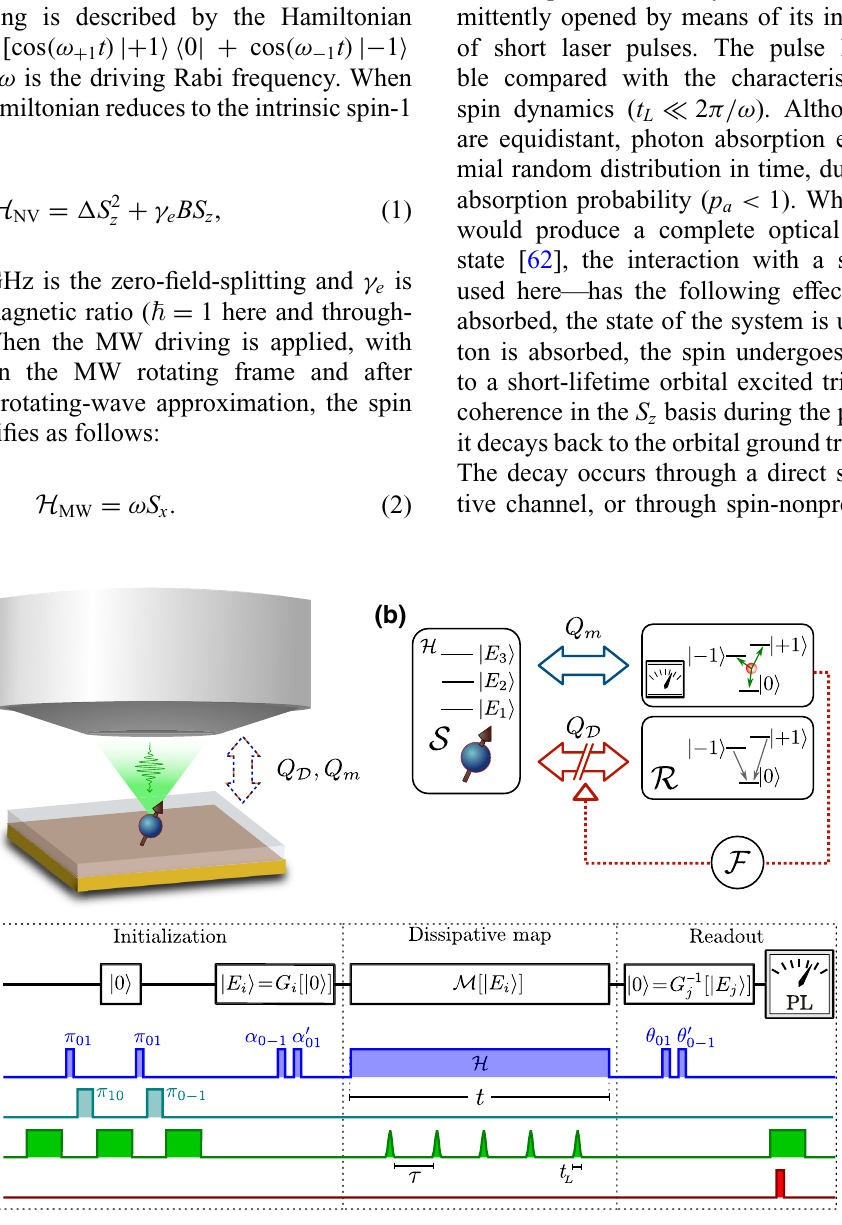
FIG. 1. (a),(b) Scheme of the spin system S in the presence of a green laser. On interaction with a laser pulse, the spin is subjected to a quantum measurement ( Q m ) of S z , and dissipation ( Q D ) toward the m S = 0 spin projection. This irreversible dissipation is analogous to putting the system in contact with an out-of-equilibrium reservoir R . Since the interaction between the system and the reservoir is conditioned by the application of a quantum measurement, the dissipation acts as an intrinsic feedback mechanism. The unitary part of the dynamics is defined by the Hamiltonian H , with eigenstates | E i (cid:2) , i = 1, 2, 3. (c) Scheme to measure energy conditional probabilities. The stochastic dissipative map M is a combination of a train of N L equidistant short laser pulses and a continuous driving under the Hamiltonian H that can be either H NV or H MW (see the main text). The total time of the experiment t = N L τ is defined in terms of the number of laser pulses and the time τ between them. The laser pulse duration t L is negligible with respect to the : | E j (cid:2) → | 0 (cid:2) enable one to prepare and read out the Hamiltonian eigenstates, continuous driving. The gates G i : | 0 (cid:2) → | E i (cid:2) and G − 1 j respectively, by exploiting the optical properties of the NV